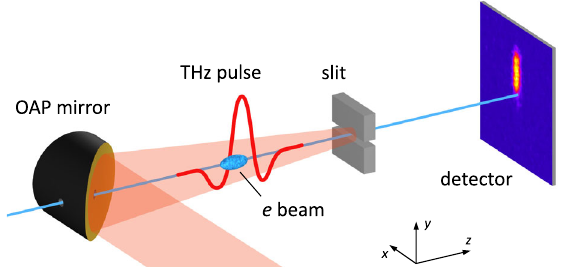
FIG. 1. Schematic of the experimental